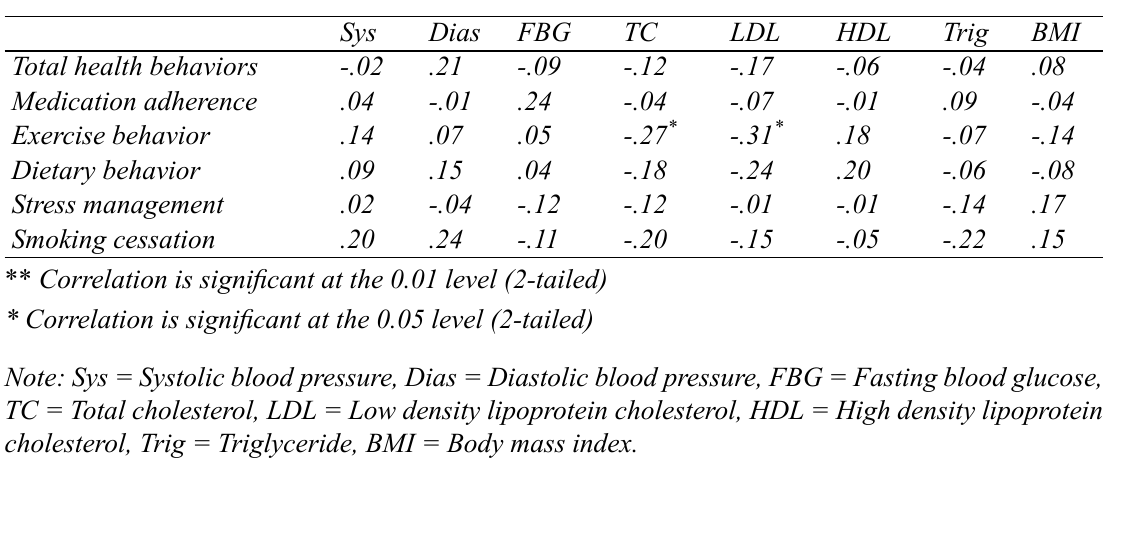
Table 5. Correlation (r) between health behaviors and clinical outcomes among MI